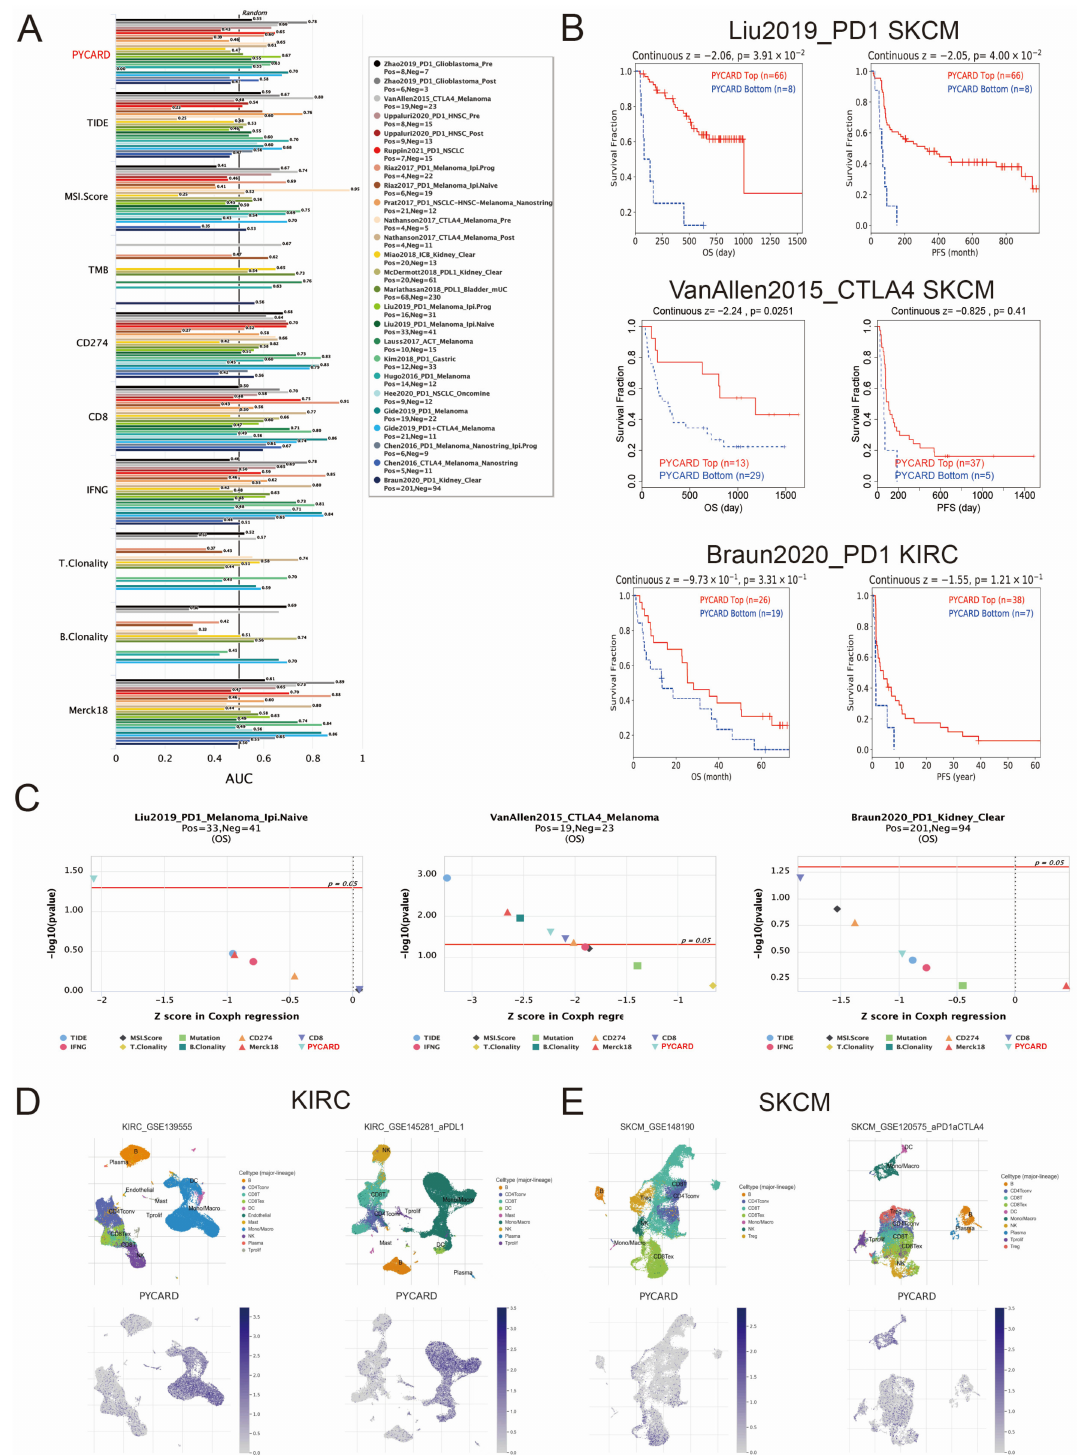
Figure 5. PYCARD expression correlated with immunotherapy response. ( A ) PYCARD predictive ability in immunotherapy cohorts. ( B ) PYCARD expression correlated with prognosis in SKCM and KIRC cohorts. ( C ) The comparison of PYCARD as a biomarker with other published biomarkers in SKCM and KIRC cohorts. ( D , E ) Single-cell analysis of PYCARD expression of immune cells in KIRC and SKCM